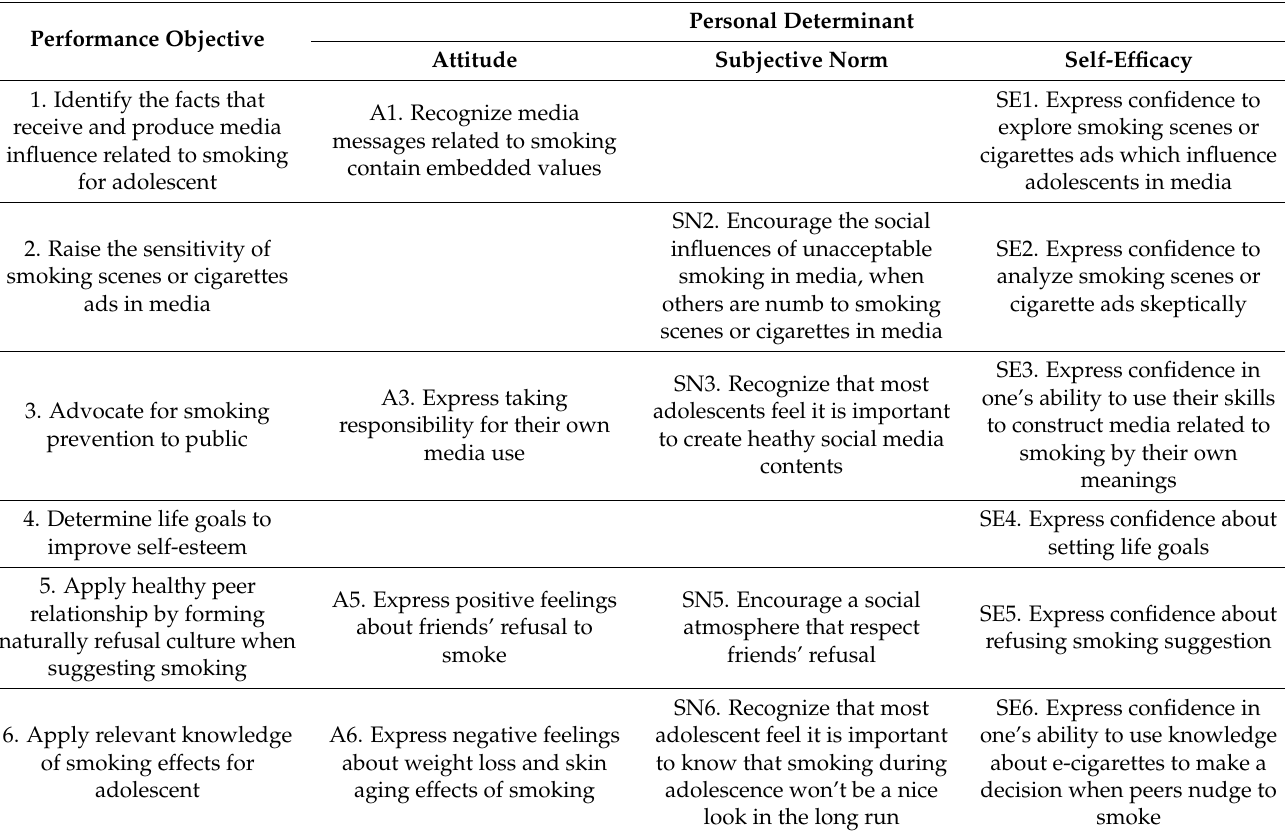
Table 1. The matrix of change